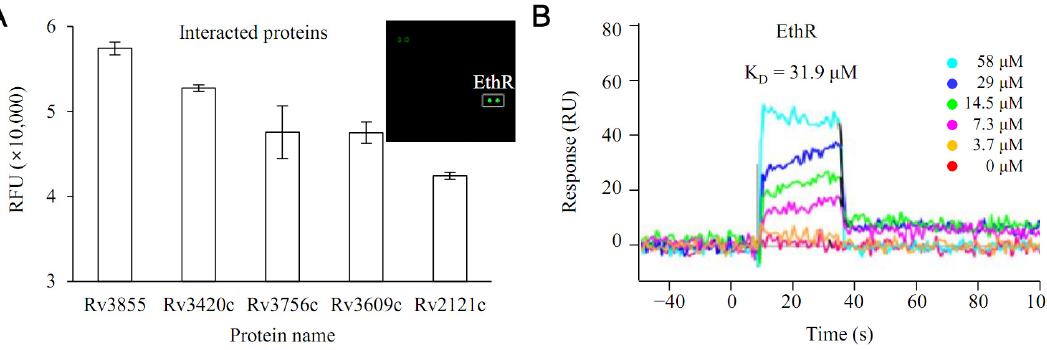
Figure 2. Interaction between Rv0560c protein and EthR protein. ( A ) A protein microarray experiment using biotinylated Rv0560c protein confirmed that Rv3855 (EthR) had the most potent interaction with Rv0560c protein among all proteins of M. tuberculosis . ( B ) The interaction of EthR with Rv0560c was verified through SPR (surface plasmon resonance).